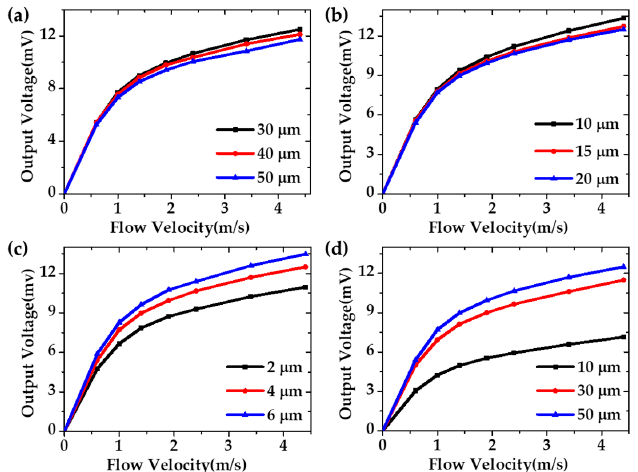
Figure 4. The simulation results of voltage and flow velocity with different structure parameters. ( a ) Distance between the thermistors and the heater (D 1 ). ( b ) Distance between the air-trench and the heater (D 2 ). ( c ) Width of the air-trench (W). ( d ) Depth of the thermal isolation cavity (H).